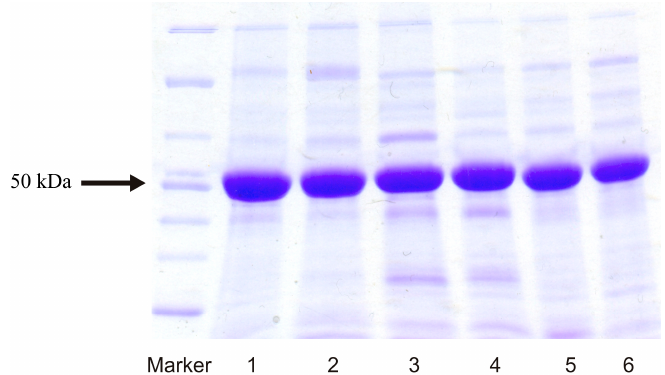
Figure 2. SDS-PAGE of final preparations of recombinant CYP enzymes. Two-hundred pmol of CYP1A1 (lane 1), CYP1A1-S122A (lane 2), CYP1A2 (lane 3), CYP1A2-T124V (lane 4), CYP1B1 (lane 5) and CYP1B1-A133S (lane 6) was loaded onto gradient 4%–20% gel. The arrow indicates a protein band having a molecular mass of ~50 kDa.